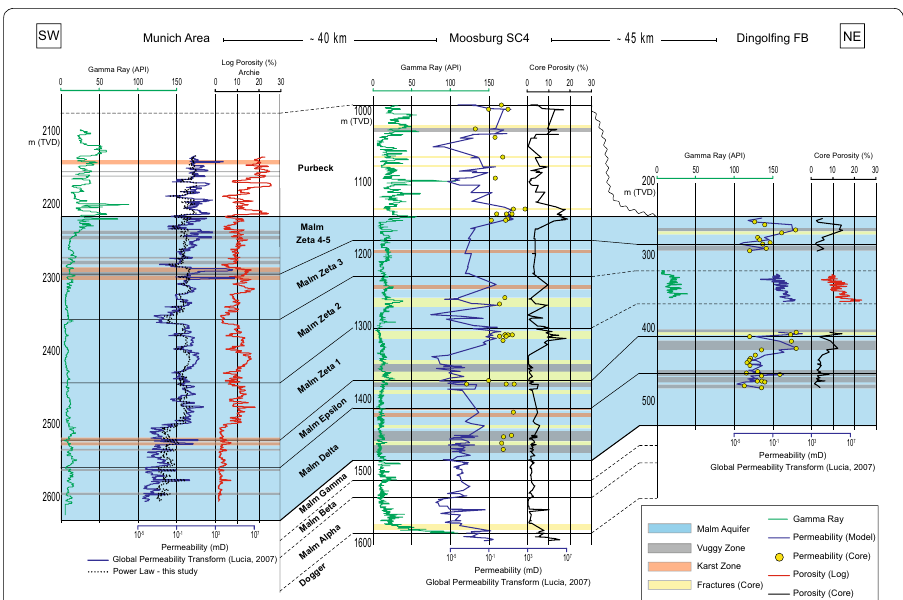
Fig. 16 Correlation of hydraulic parameters for the Malm aquifer in a SW–NE section from Munich to Dingolfing. Porosity and permeability were measured on rock cores for the wells MSC-4 and DGF-FB— permeability logs were calculated by permeability models (blue lines). Gamma ray was measured and porosity log calculated by electrical resistivity logs. Karstified and fractured zones were identified by Image Log (Munich well) or by rock core description. Note logarithmic scale for